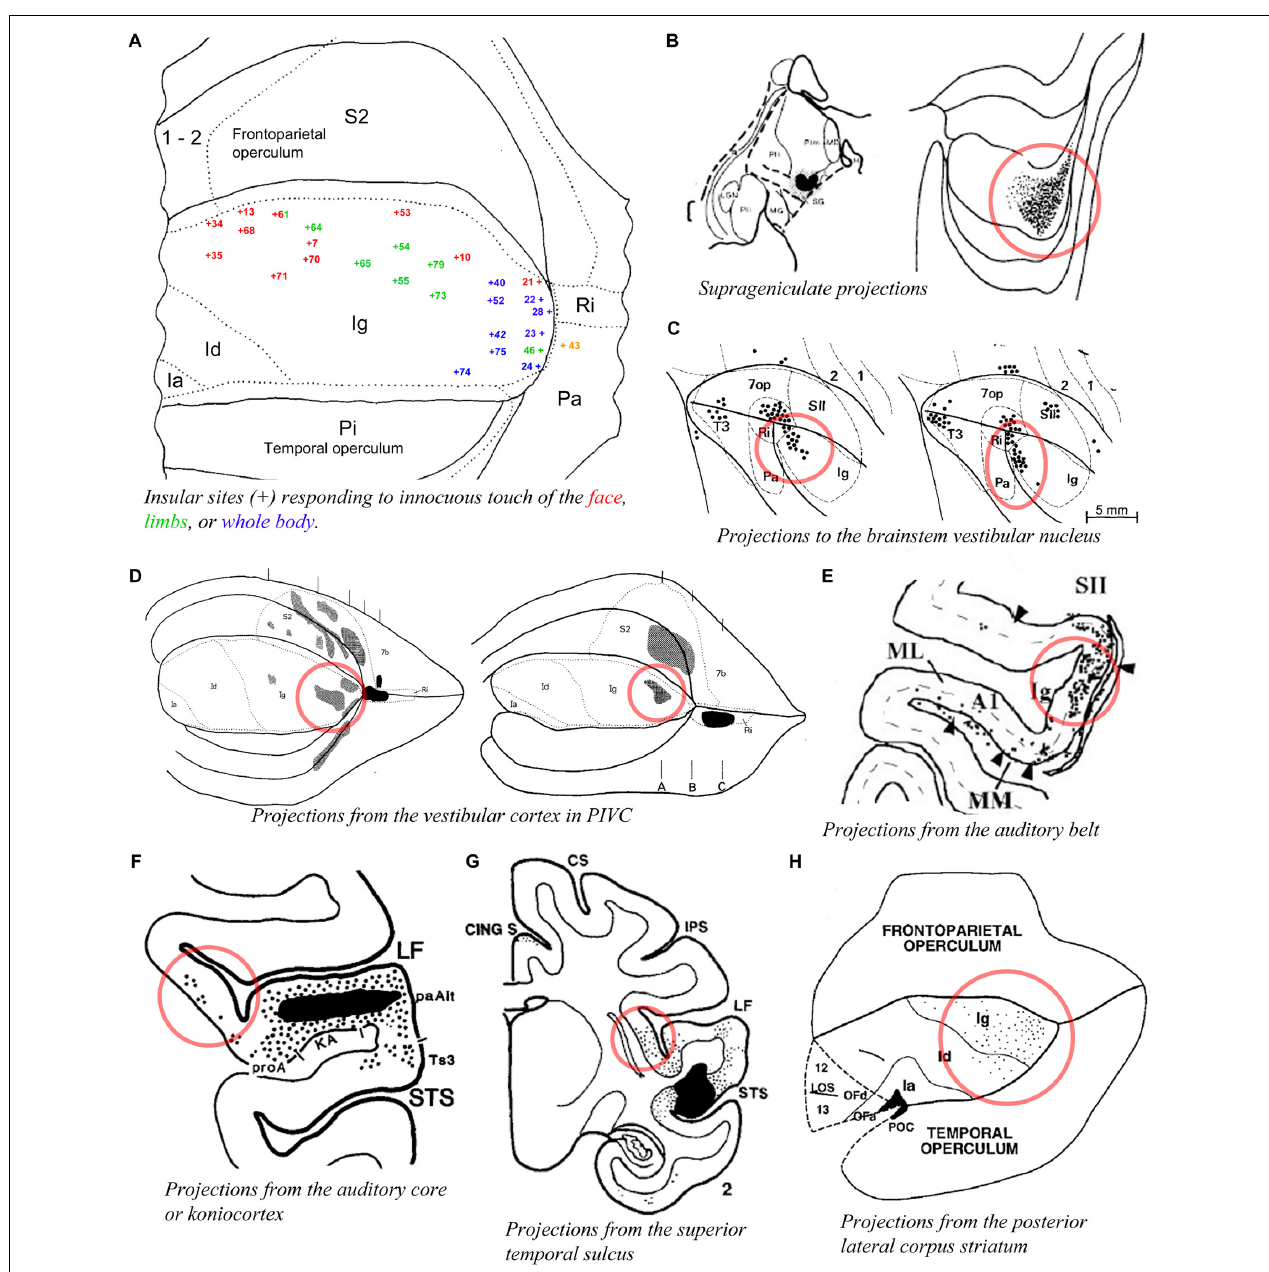
FIGURE 5 | Activity and connectivity of the posterior granular areas of the macaque insula. (A) Flat map drawing of the insular cortex and adjacent opercula summarizing the localization (+ symbol) of microelectrode recording sites with single- or multi-unit responses to innocuous somatic stimuli on the face (red) or limbs (green), or of the whole body with, in some cases, a simultaneous response to auditory stimuli (blue) in the rhesus macaque monkey ( n = 3). We consider that the dorsal region (red and green) corresponds very likely to our dorsal dysgranular area, the posterior region (blue) to our posterior granular areas (see text) (Schneider et al., 1993). (B) Plot of an injection site of tritiated amino acids (TAA) in a small thalamic region corresponding to the suprageniculate nucleus (SG) in case RM19L (left) and distribution of the anterograde labeling produced by this injection in the posterior end of the insula, likely corresponding to our posterior granular areas, Igd, and Igv (Burton and Jones, 1976). (C) Flat map plot of retrograde labeling in the posterior insula in cases M1 (left) and M2 (right) with an injection of horse-radish-peroxidase (HRP) in the brainstem vestibular nucleus (Akbarian et al., 1994). (D) Flat map plot of anterograde labeling in the posterior insula in cases RM4 (left) and RM3 (right) with an injection of TAA in the retroinsular (vestibular) cortex (Friedman et al., 1986). (E) Flat map plot of retrograde labeling in the posterior insula in cases MC with an injection of fast blue in area CM of the auditory belt (Smiley et al., 2007). (F) Coronal plot of retrograde labeling in the posterior insula with an injection of FB in the koniocortex-primary auditory area (KA) of the auditory cortex (Cipolloni and Pandya, 1989). (G) Coronal plot of anterograde labeling in the posterior insula with an injection of TAA in the superior temporal sulcus (STS). (H) Flat map plot of retrograde labeling in the posterior insula in case MS56 with an injection of WGA-HRP in the posterior lateral corpus striatum (Seltzer and Pandya, 1991). All illustrations in the panels of this figure were adapted with permission from the publishers of the cited